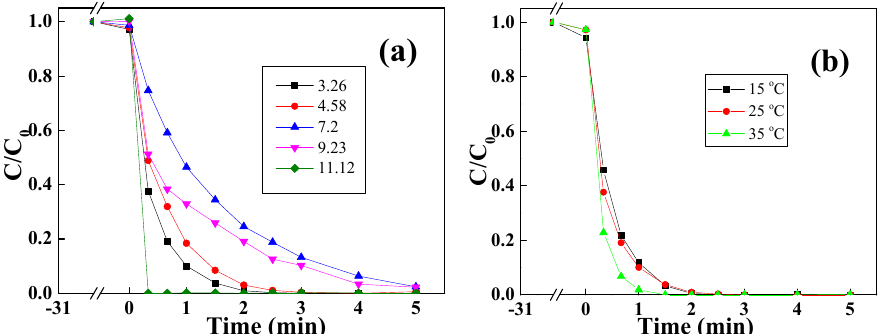
Figure 5. Impact of ( a ) pH value and ( b ) solution temperature on the performance of N − PPB600 ([catalyst] 0 = 0.5 g/L, [BPA] 0 = 0.02 mM, [PMS] 0 = 1.5 mM).